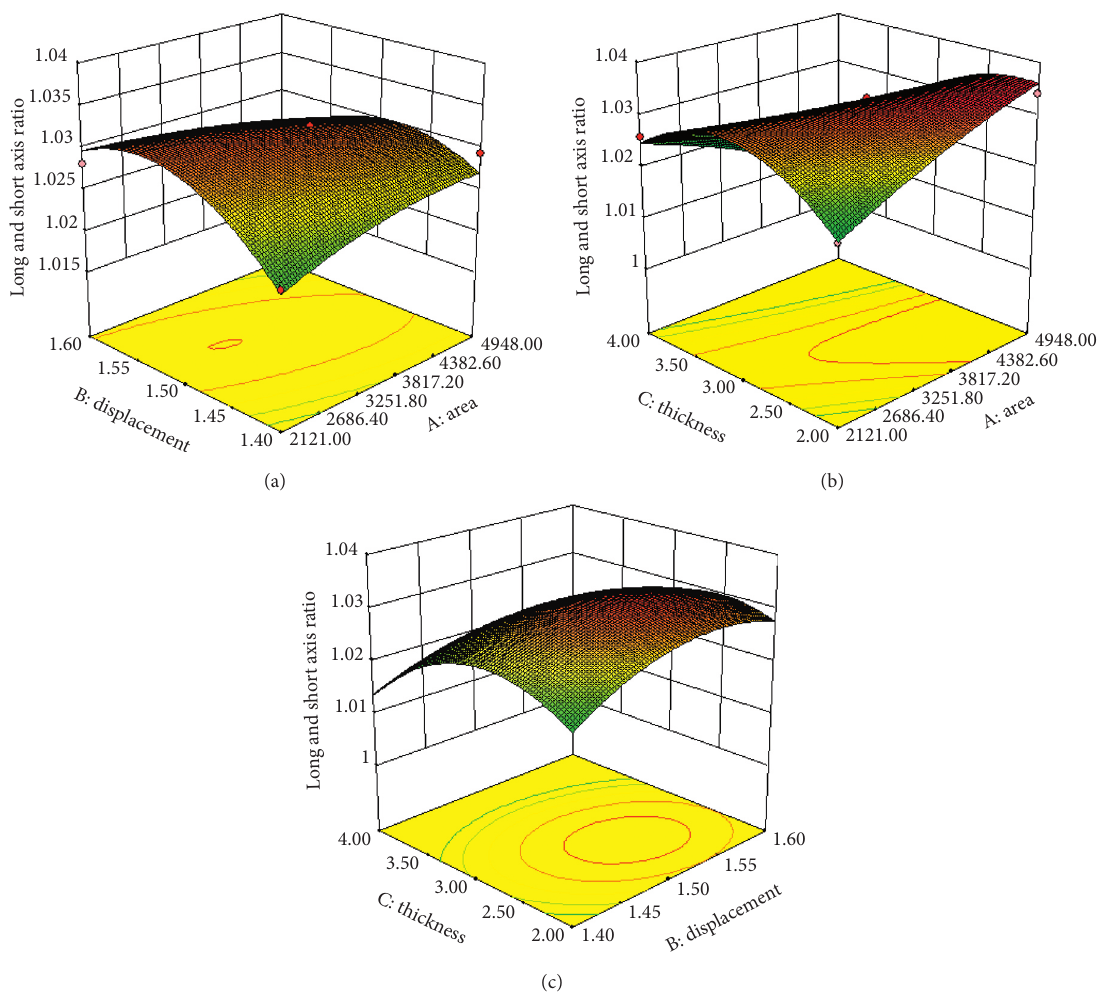
Figure 10: Effect of experimental parameters on long and short axis ratio. (a) Effect of area and displacement. (b) Effect of area and thickness. (c) Effect of thickness and